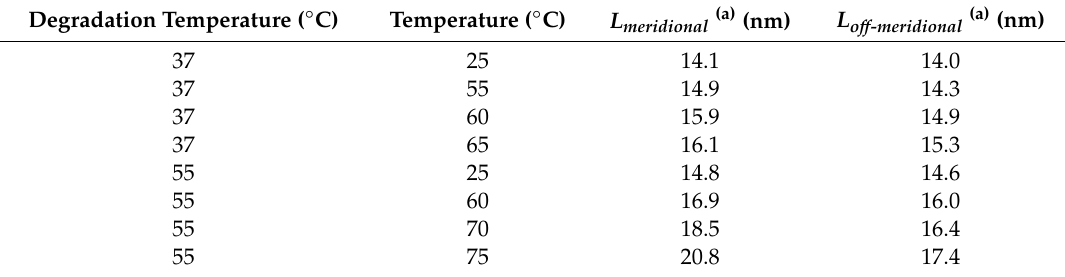
Table 4. Spacings of the reflections observed in SAXS patterns recorded at different temperatures during heating of hydrolytically degraded samples (pH 10, 27 days) at 37 °C and (pH 3, 27 days) 55 °C.